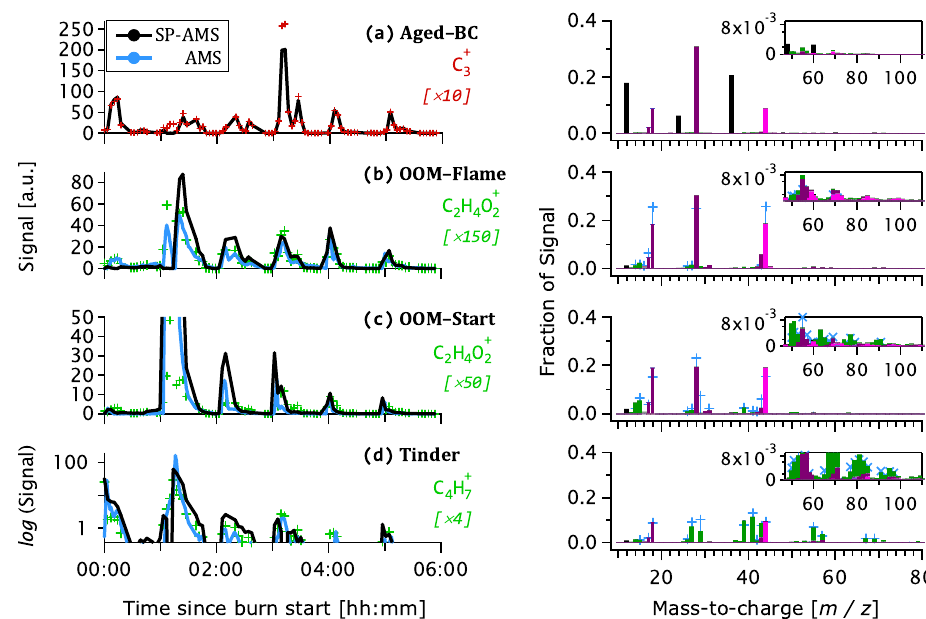
Figure 6. PMF factors for aged-emissions data. Panels are analogous to Fig. 5. Signals for (c) OOM–Start are drawn off-scale to show key structural features. Time series (d) is plotted on a log-scale due to its low intensity, with an axis minimum of the OM limit of detection ( 3 σ) . In the mass spectra of (d) , no CO + signal is shown as that species was below its detection limit (see